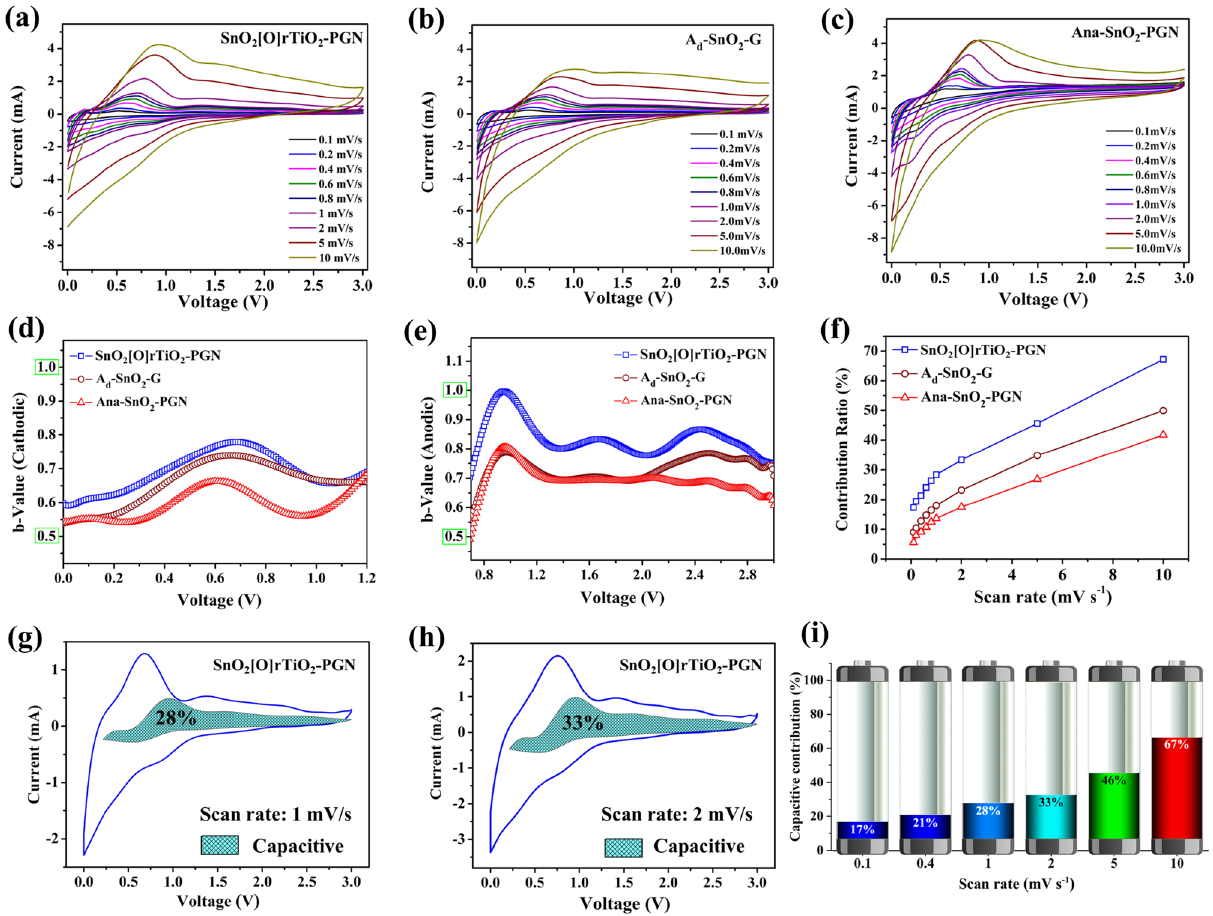
Figure 5. Energy storage behavior kinetics analysis. ( a – c ) CV scans of the SnO 2 [O]rTiO 2 -PGN, A d -SnO 2 -G, and Ana-SnO 2 -PGN anodes, respectively, at various speeds (0.1–10 mV s −1 ). ( d , e ) Plots of b-value versus voltage of cathodic and anodic scan, respectively. ( f ) Pseudo-capacitive contribution ratio (indicated as “contribution ratio, %”) under various scan rates. ( g , h ) The separation of capacitive and diffusion-controlled process contributions under 1 and 2 mV s −1 . ( i ) Normalized contribution ratio bar plot of SnO 2 [O]rTiO 2 -PGN under various scan